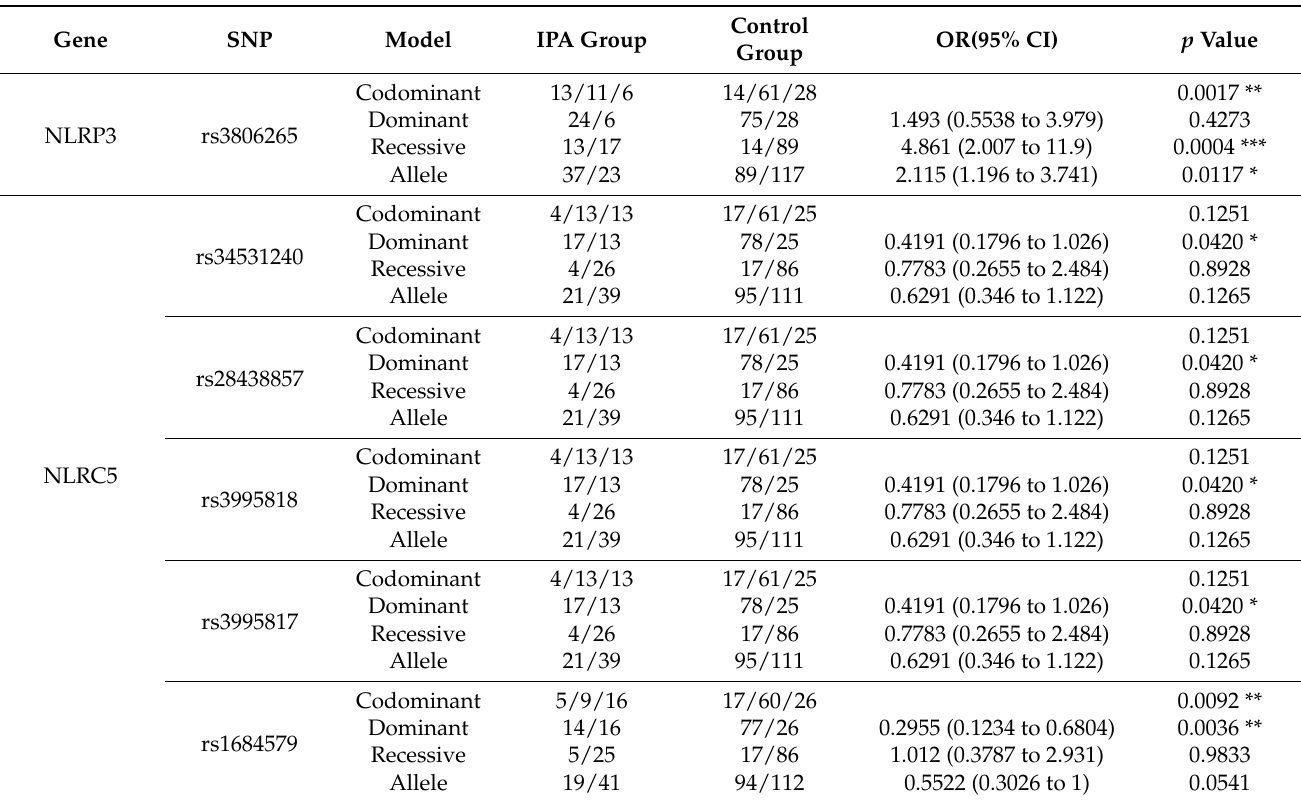
Table 5. Genotype distribution of NLRP3 rs3806265 and NLRC5 rs34531240, rs28438857, rs3995818, rs3995817, rs1684579 in IPA group and controls.